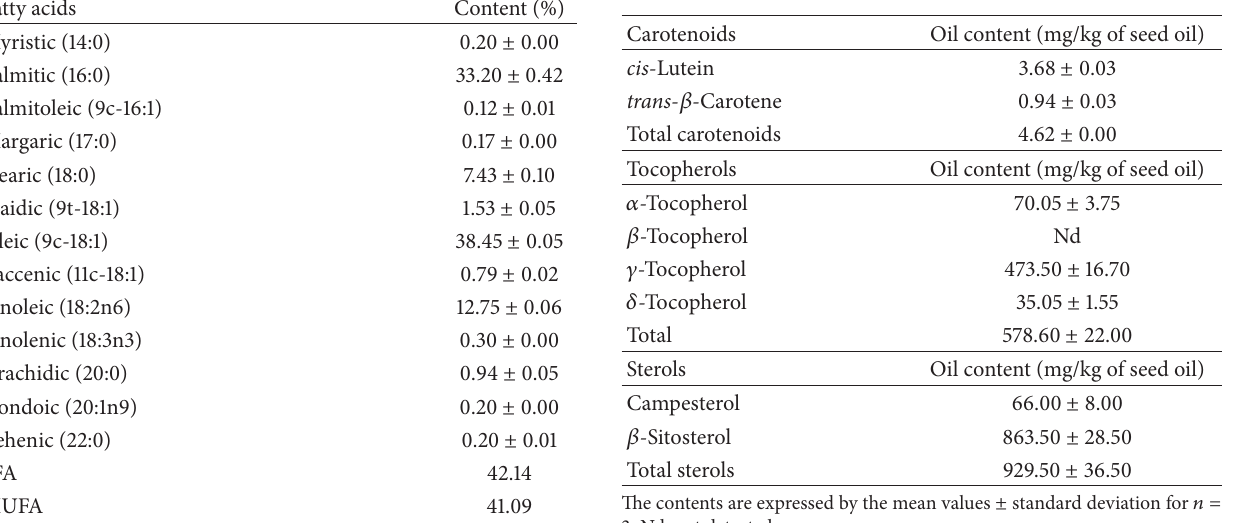
Table 5: Carotenoid, tocopherol, and sterol contents of Lannea kerstingii seed